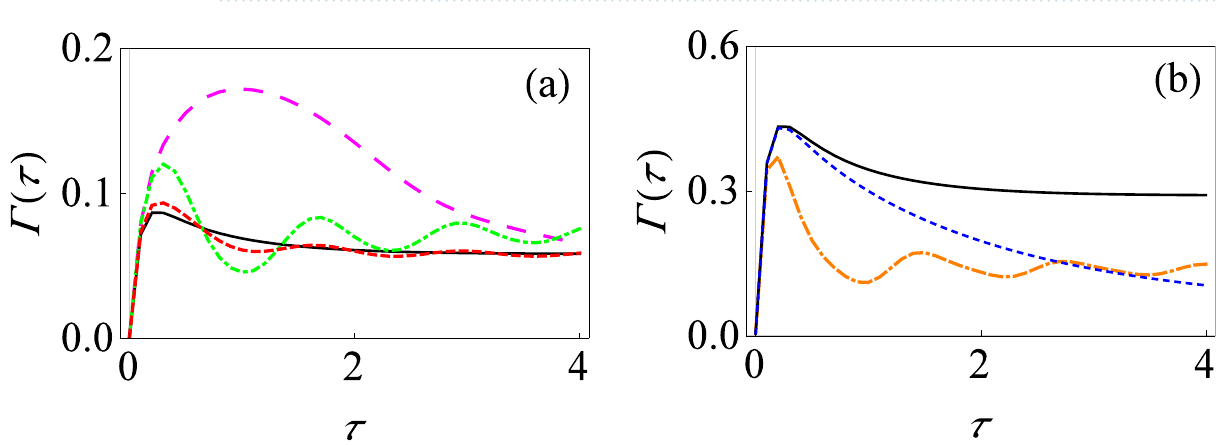
Figure 3. Effective decay rate for the driven population decay model with the RWA. ( a ) Graph of Ŵ(τ) versus 0 and γ( t ) 0 with τ in the presence of time-dependent driving fields: α( t ) ε 0 t ( V 0 /�) sin (� t ) , β( t ) = + = = 1 and (cid:31) 5 and (cid:31) 5 and (cid:31) 5 (dashed, red curve), V 0 5 1 (long-dashed, magenta curve), and V 0 V 0 = = = = = = 0 and γ( t ) 0 . We remind the ε 0 t , β( t ) (dot-dashed, green curve). The solid black curve shows α( t ) = = = 1 . Here we have used G 1 and we have set ε 0 0.01 reader that we have used dimensionless units with (cid:31) = = = 10 . ( b ) We now have α( t ) 0.2 (dashed, blue 1 )/χ and γ( t ) 0 with χ ( e − χ t ε 0 t , β( t ) and ω c = = = − − = = 5 (dot-dashed, orange curve); α( t ) 0 with υ 0 and υ t and γ( t ) ε 0 t , β( t ) ε 0 t , β( t ) curve); α( t ) = = = = = = 10 0.05 and ω c 0 (solid, black curve). We now have G γ( t ) = = =